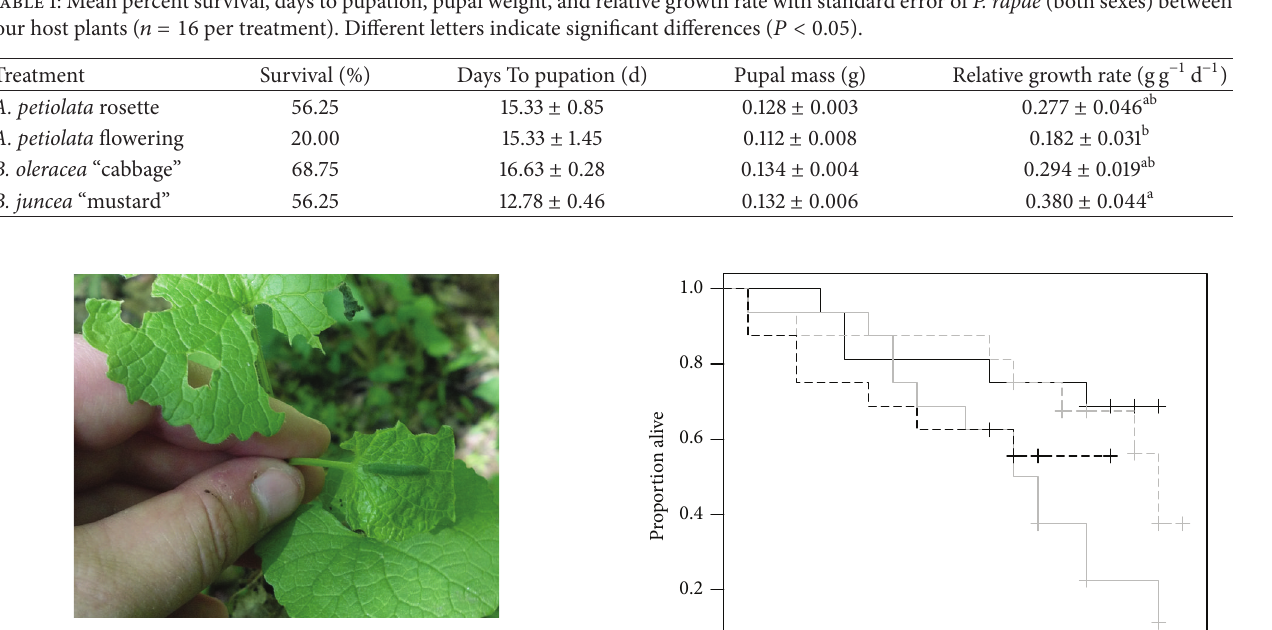
Figure 1: Mature P. rapae caterpillar consuming rosette A. petiolata in Wooster, OH. Photo taken on May 11, 2012, by SLD.